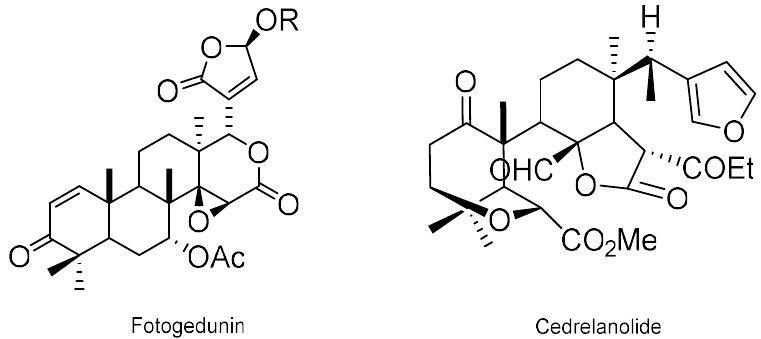
Figure 11. Metabolites extracted from two Cedrela species ( Cedrela salvadorensis and Cedrela dugessi ).